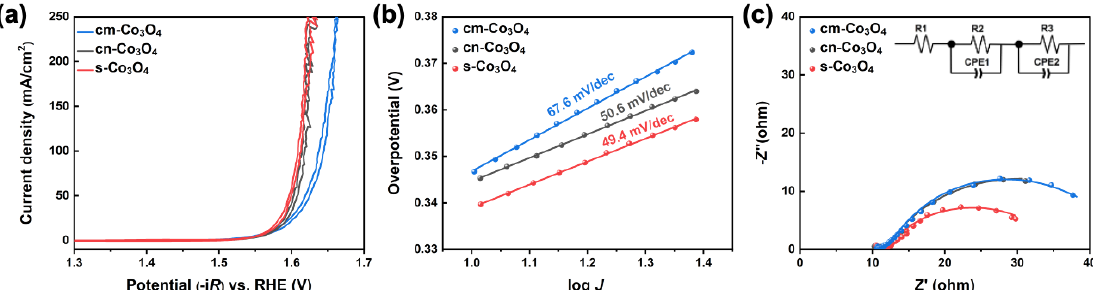
Figure 7. Electrochemical performance of s -Co 3 O 4 , cn -Co 3 O 4 , and cm -Co 3 O 4 for the OER. ( a ) CV curves collected in 1 M KOH solution at a scan rate of 2 mV/s at room temperature and ( b ) the Tafel plots extracted from ( a ). ( c ) Nyquist plots over a broad frequency range from 0.01 to 100,000 Hz at 0.7 V vs. Hg/HgO with a 0.01 V amplitude.